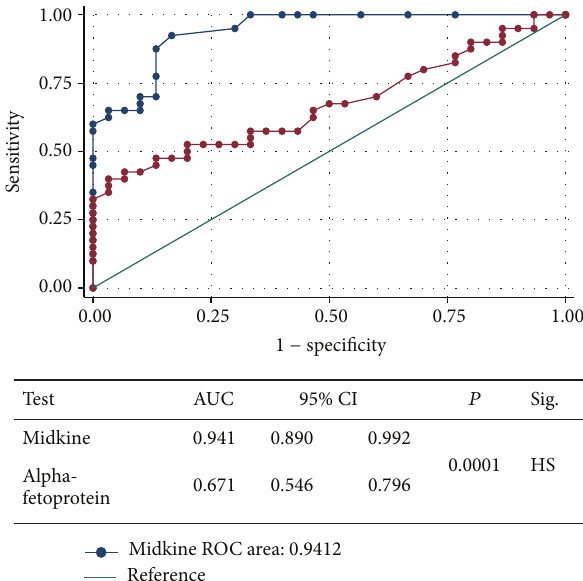
Figure 1: ROC curve showing comparison of the diagnostic perfor- mance of serum MDK and AFP for discriminating HCC group from chronic liver disease